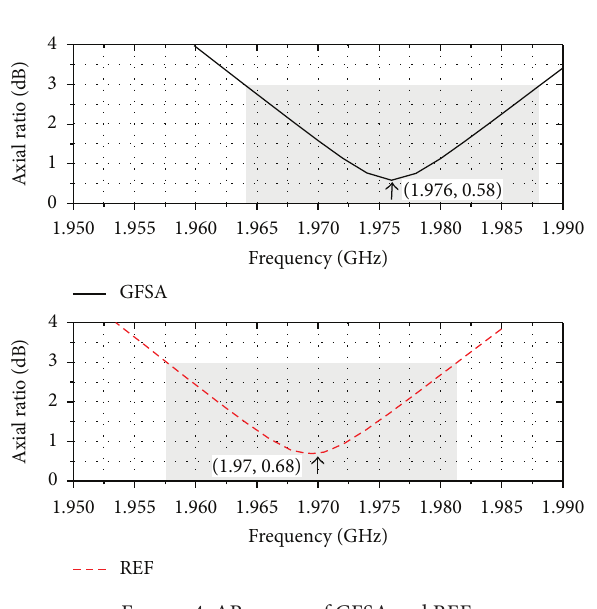
Figure 4: AR curves of GFSA and